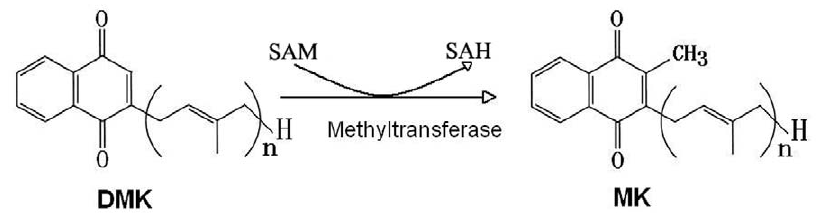
Figure 1. Methylation reactions in the biosynthetic pathway of MK. The length of the isoprenoid side chain ( n ) varies depending on the species. SAM, S-adenosyl-L-methionine; SAH, S-adenosyl-L-homocysteine; DMK, demethylmenaquinone; MK, menaquinone.